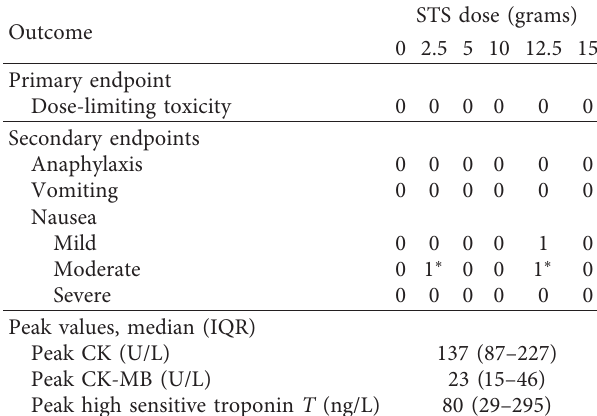
Table 2: Outcome parameters. Table 1: Baseline characteristics.